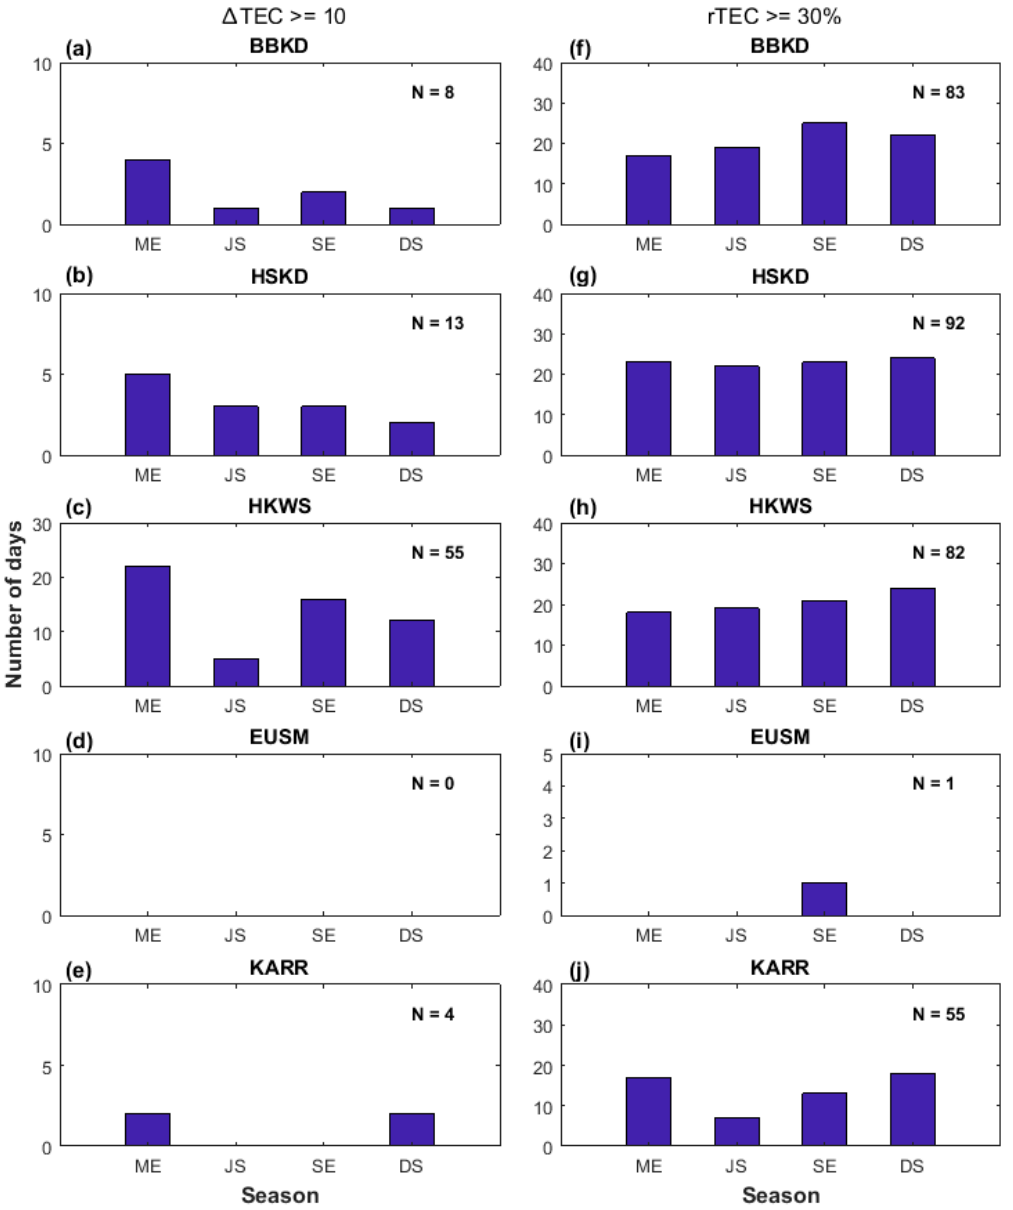
Figure 5. Seasonal variations of the number of days of observed TEC enhancements during 2016–2018 under Kp < 3 condition. The variations in ( a – e ) were derived based on the absolute TEC deviation and ( f – j ) through relative TEC deviation. The total number of days of TEC enhancements for all seasons is denoted by N. The seasons were written for short as ME (March equinox), JS (June solstice), SE (September equinox), and DS (December solstice).